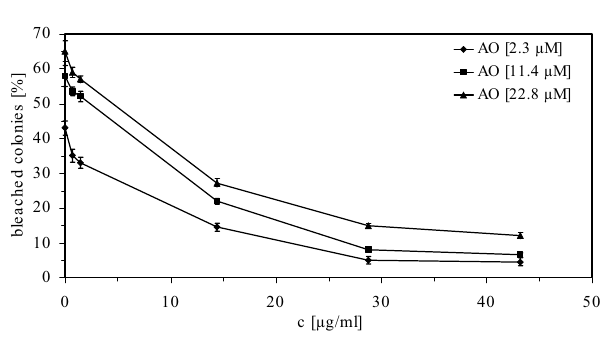
Figure 3 A plot of percentage of bleached colonies of E. gracilis vs. concentration of BBI alkaloid fraction at 3 concentrations of acridine orange (AO). Symbols and brackets have the same meaning as in Fig. 2.